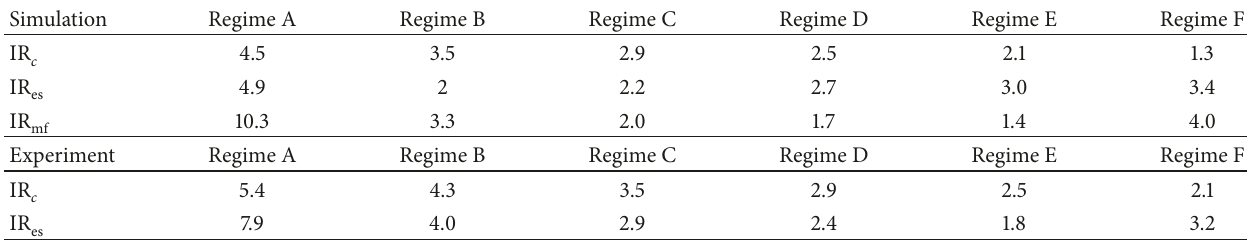
Table 9: Comparison between simulation results and experimental data, as IR values.